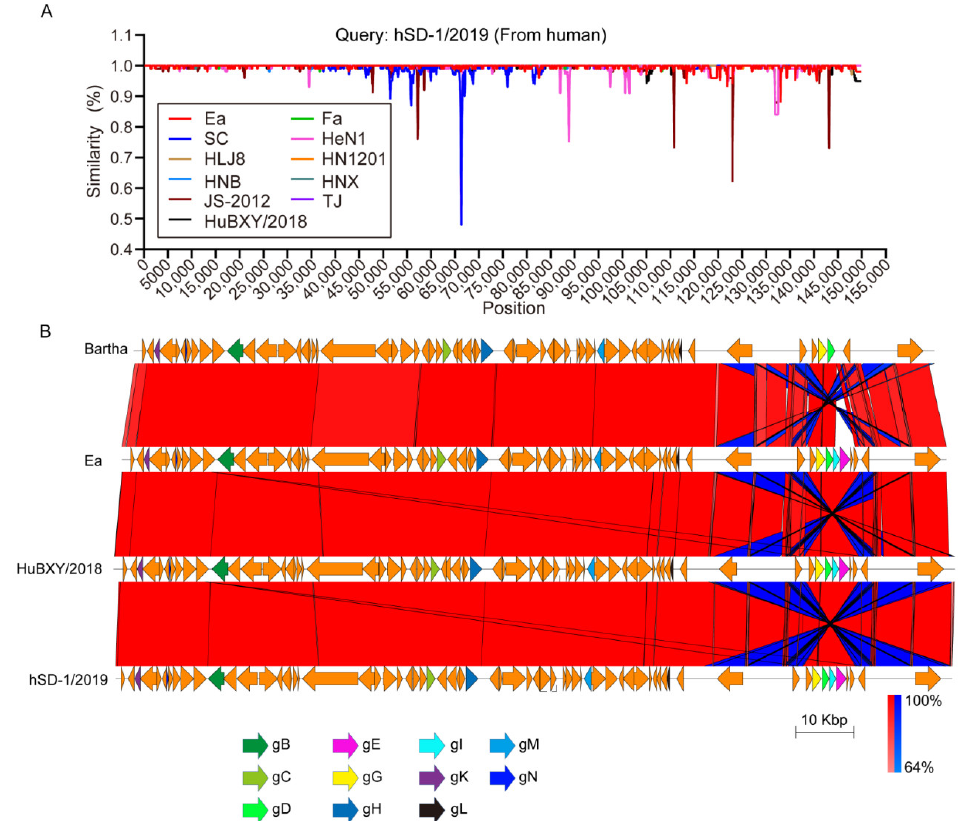
Figure 1. Sequence comparisons of human-originated and pig-originated PRV strains ( A ) Nucleotide similarities of the human-originated PRV strain hSD-1/2019 and the pig-originated PRV variant strains (HeN1, HLJ8, HN1201, HNB, HNX, JS-2012, TJ, and HuBXY/2018), as well as the pig-originated PRV classic strains (Ea, Fa, SC). ( B ) Comparative genomic analyses of the human-originated PRV strain hSD-1/2019, the pig-originated PRV variant strain HuBXY/2018, the pig-originated PRV strain Ea, and the vaccine strain Bartha. Color code stands for BLASTn identity of those regions between genomes. Arrows in the same colors represent putative CDSs with similar roles in different genomes.